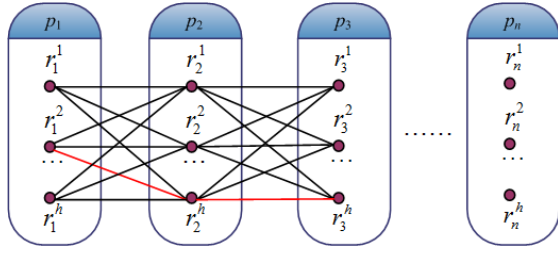
Figure 8. Global optimization searching algorithm.